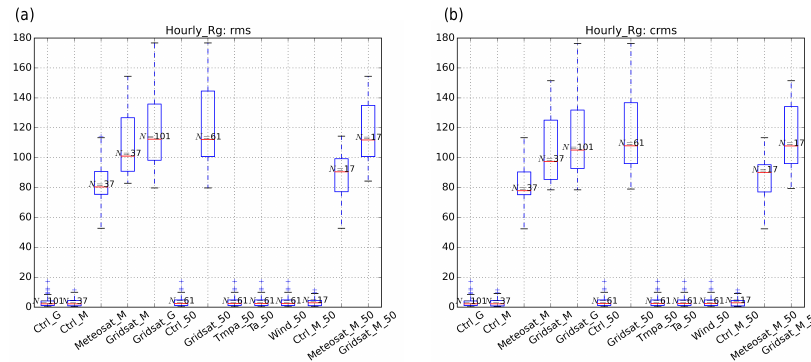
Figure 6. Box plots of (a) RMSD and (b) cRMSD for hourly surface solar radiation flux ( R g ) .